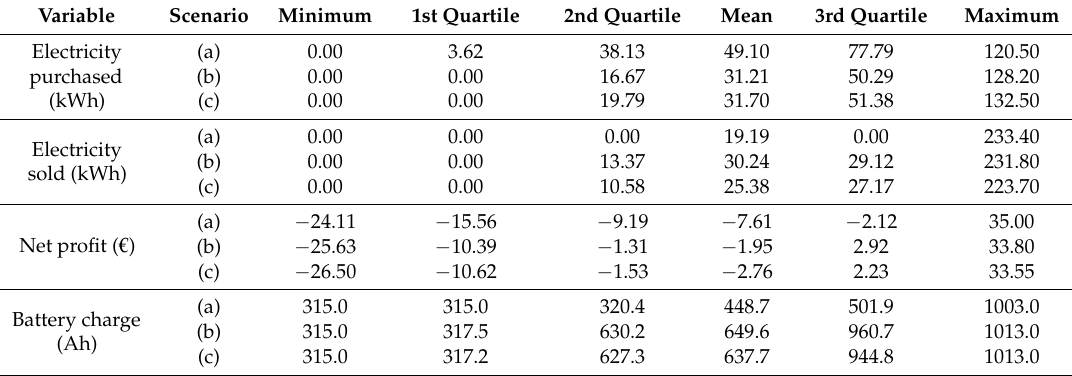
Table 5. Case study 2: Summary of descriptive